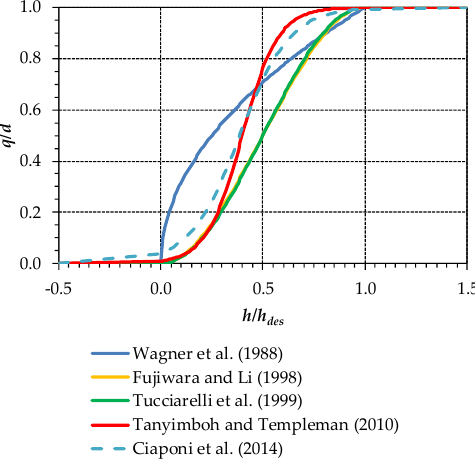
Figure 1. Ratio of outflow q to demand d as a function of the ratio of the generic pressure head h to the desired pressure head h des for the various formulations.